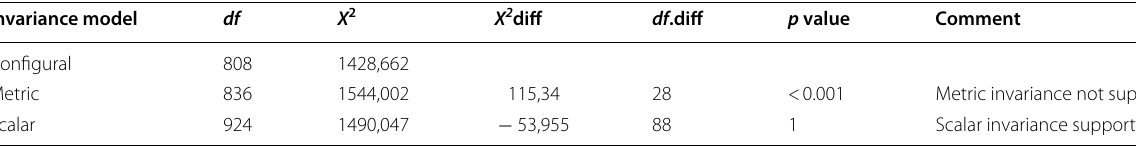
Table 5 Nested model comparison (hypotheses testing)